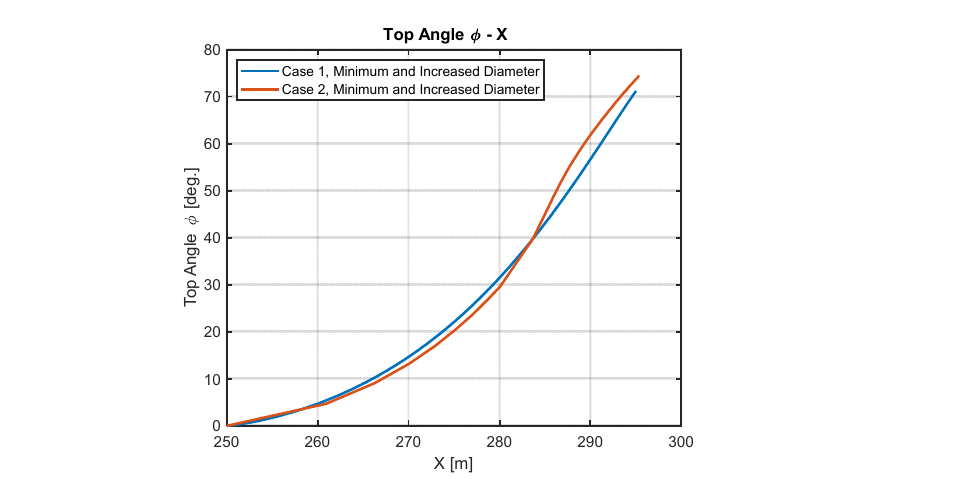
Figure 13. Top angle at the fairlead as a function of horizontal distance from the anchor to the buoy.